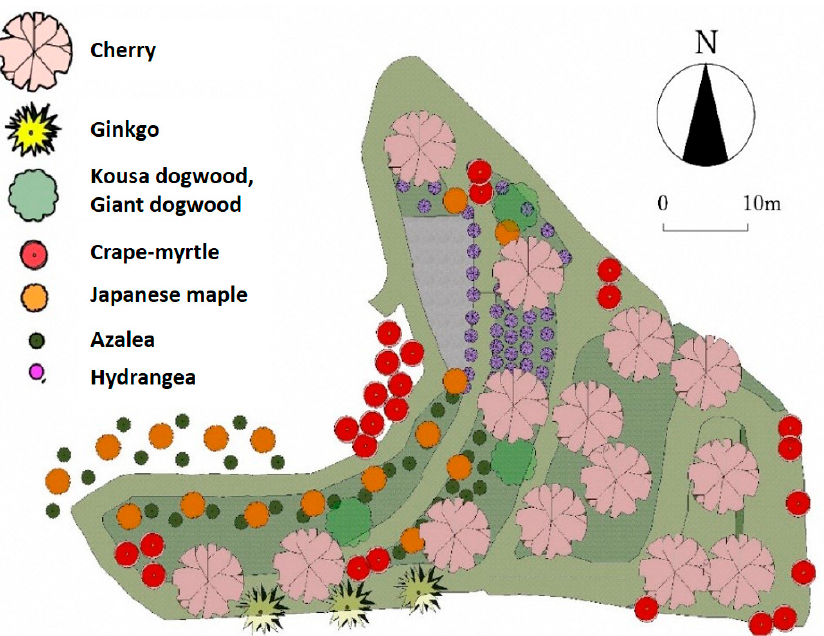
Figure 3. Plan of the observation site (created by Kazuo Asahiro [the fourth author]).